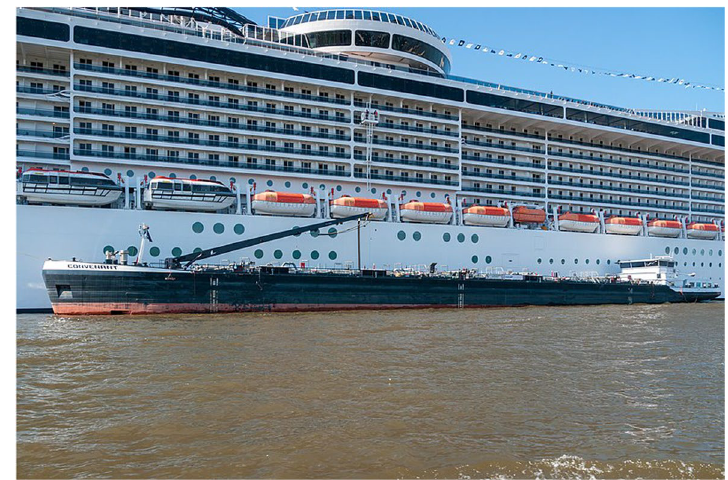
Fig. 7 Bunkering for a cruise vessel (source: Wikimedia Commons the image is used under a CC BY-SA 4.0 license)